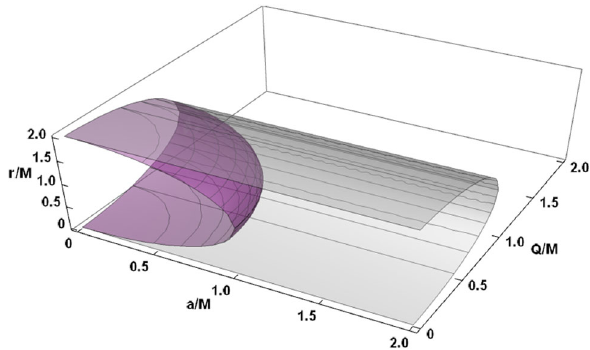
Fig. 18 Kerr–Newman solution–theequatorialplane.Plotofthehori- zons r ± / M (purple) and static limit r + (cid:9) / M (gray) as functions of a / M and Q / M – Eq.